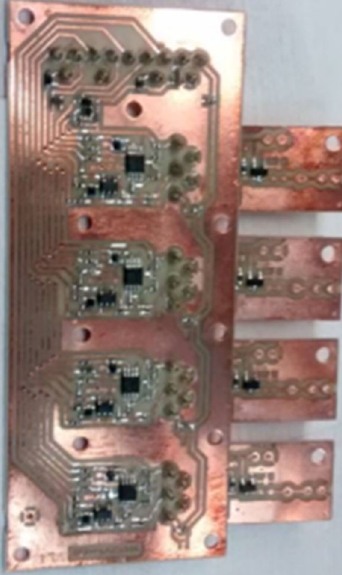
Fig. 6 Photo of the CC3 Ge 4-channel readout circuit. Each circuit serves 4 channels. The very front end components (see Fig. 5) are located on the 4 small PCBs which are connected with low activity pin-contacts to the main board; this allows us to replace individually for each channel the components of the very front end, and in particular the rather sensitive JFET